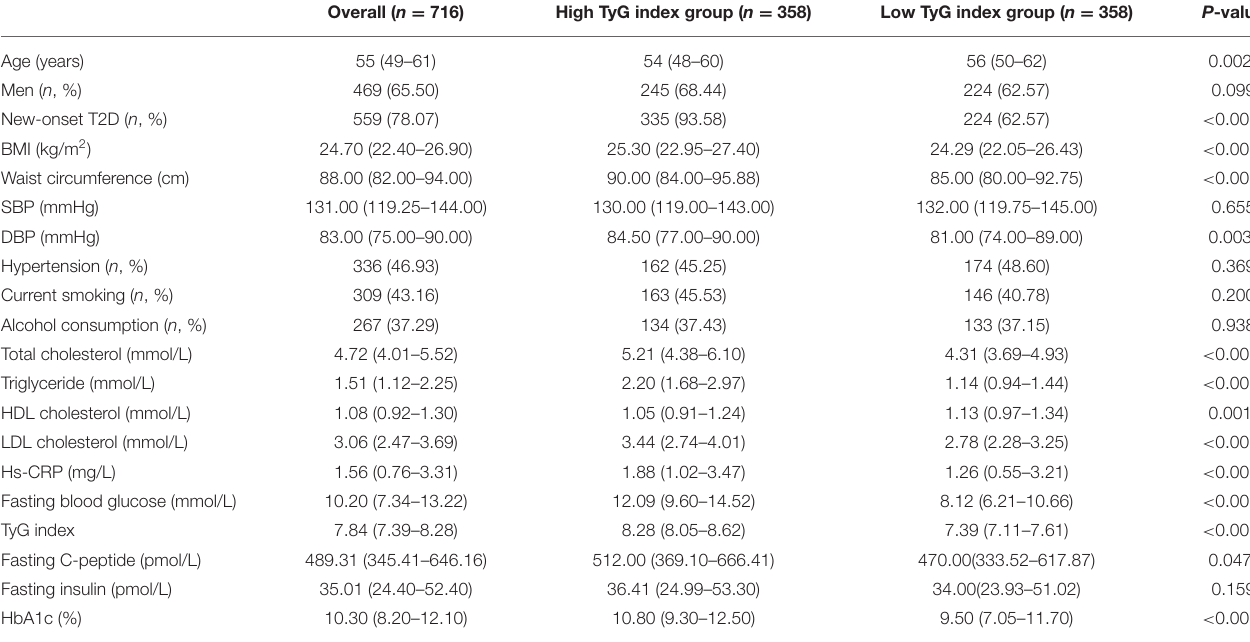
TABLE 1 | Baseline characteristics of the subjects stratified according to TyG